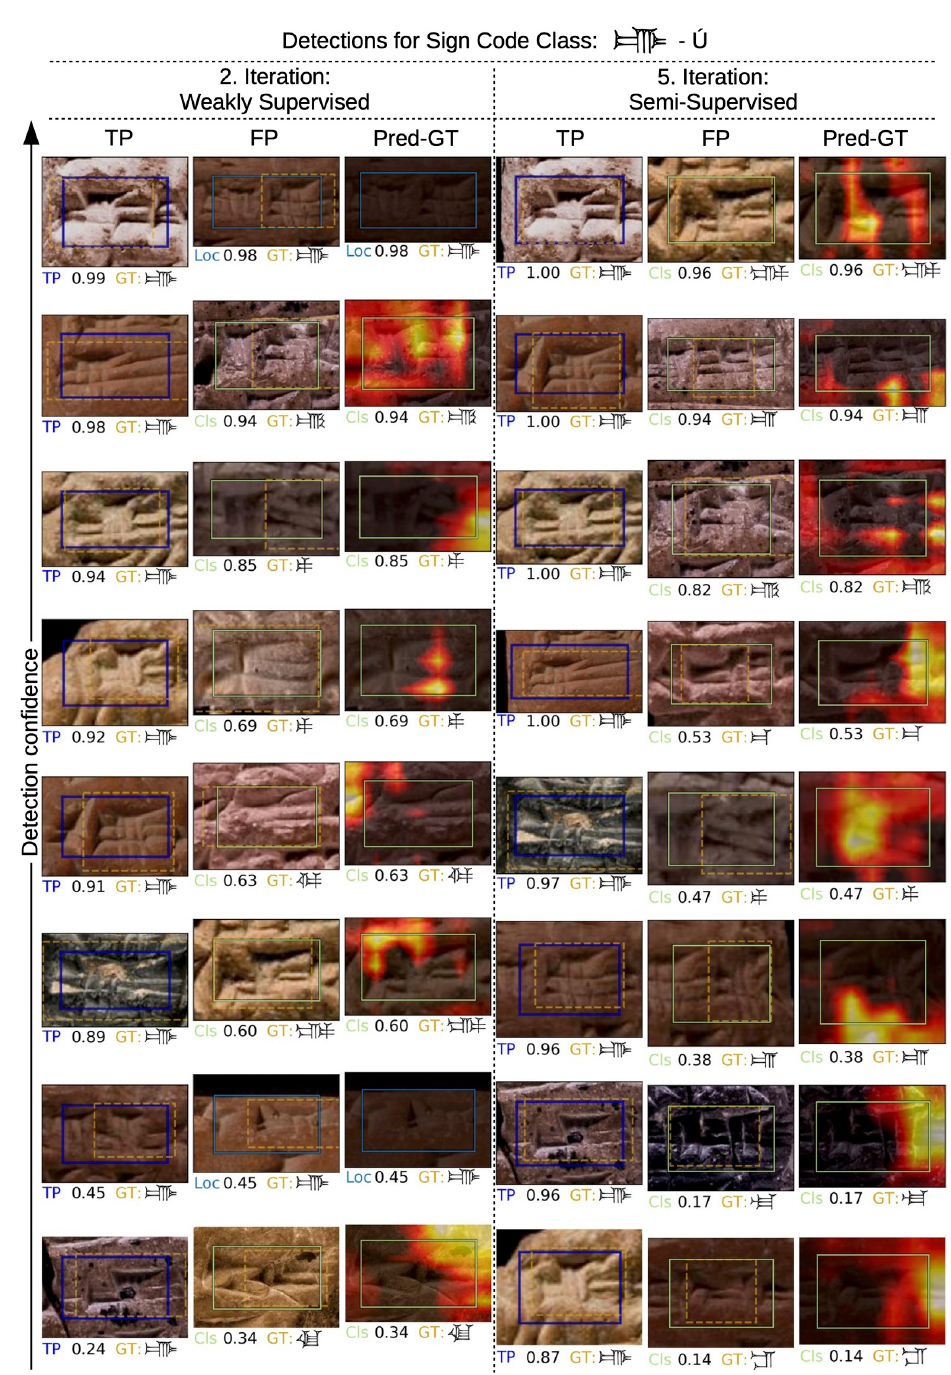
Fig 7. Individual sign detections for single sign code class at two different iterations of iterative training. For each iteration we show in the first two columns the eight most confident TP and FP sign detections on our test set. Each sign detection is represented as a solid bounding box, while the golden dashed box indicates the ground truth annotation (with the largest overlap with the predicted box). Below each detection we show the detection category, the detection confidence, and the actual ground truth (GT) sign code class. The detection category is either TP or one of three FP categories: Loc, BG, Cls. The third column of each iteration visualizes for each FP detection of the second column which image area contributed most to the detection error. Despite high intra-class variance and inter-class similarity of cuneiform signs the sign detector produces good results, makes plausible mistakes, and improves further in the semi-supervised case. Image material by the